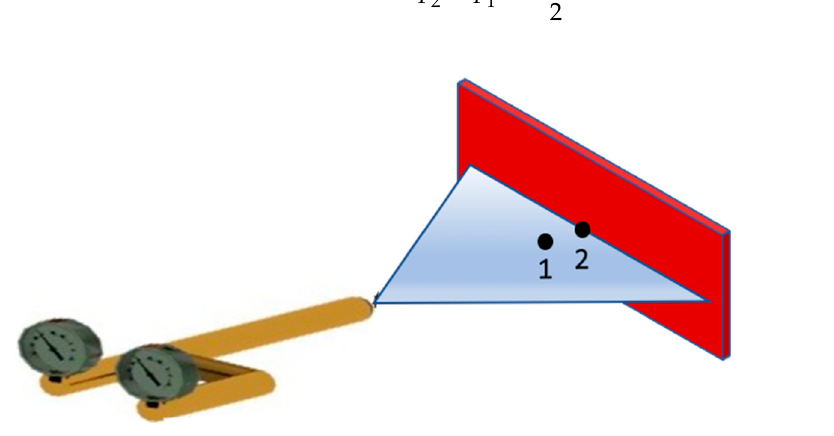
Figure 3. Schematic representation of a water-air mist impinging a vertical wall. Bernoulli’s equation is applied in points 1 and 2 lying in the same streamline. Point 1 is far enough from the impingement plane, so there is no upstream influence from point 2.